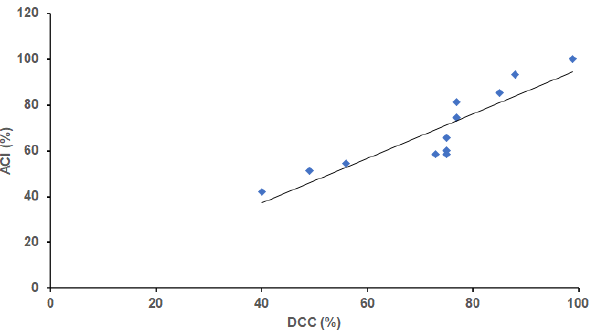
Figure 1. Correlation between antioxidant potency composite index (ACI) and declared cocoa content (DCC) in analysed chocolate samples.